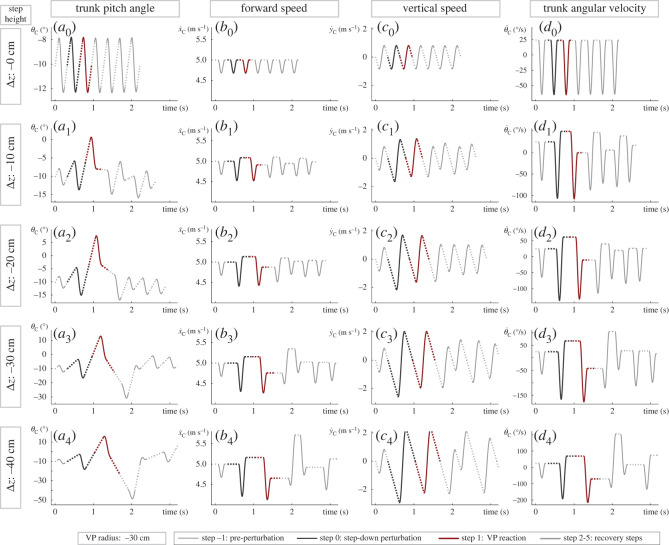
The energy curves for the leg spring (a0−a4), leg damper (b0−b4) and hip actuator (c0−c4). The sub-index ‘0’ indicates the trajectory belongs to the equilibrium state. With the increase of the system’s energy at step-down (solid black line), the leg deflects more, the leg damper dissipates more energy and the hip actuator injects more energy compared to its equilibrium condition. During the reaction step (dashed line), the hip actuator reacts to energetic change and starts to remove energy from the system. In the following steps (solid grey line), the hip regulates the energy until the system reaches to the initial equilibrium state (solid blue line). In subplot c4, the maximum value of steps 7–11 is indicated with a text and arrow because of the scaling issues.